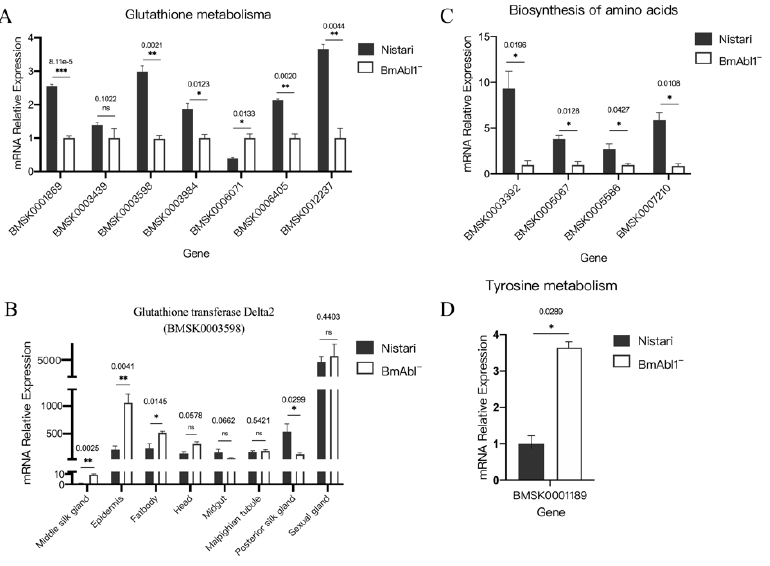
Figure 5. Verification of DEGs expression by qRT-PCR. ( A ) Verification of DEGs in glutathione metabolism pathway; ( B ) the expression of glutathione transferase Delta2 in each tissue was specifi- cally decreased in the posterior silk gland; ( C ) verification of DEGs in tyrosine metabolism pathway; ( D ) verification of DEGs in the biosynthesis of amino acids pathway. Standard deviation was calcu- lated by all biological replicates. * p < 0.01, ** p < 0.005, *** p < 0.001, t test, each group had three biological replicates.